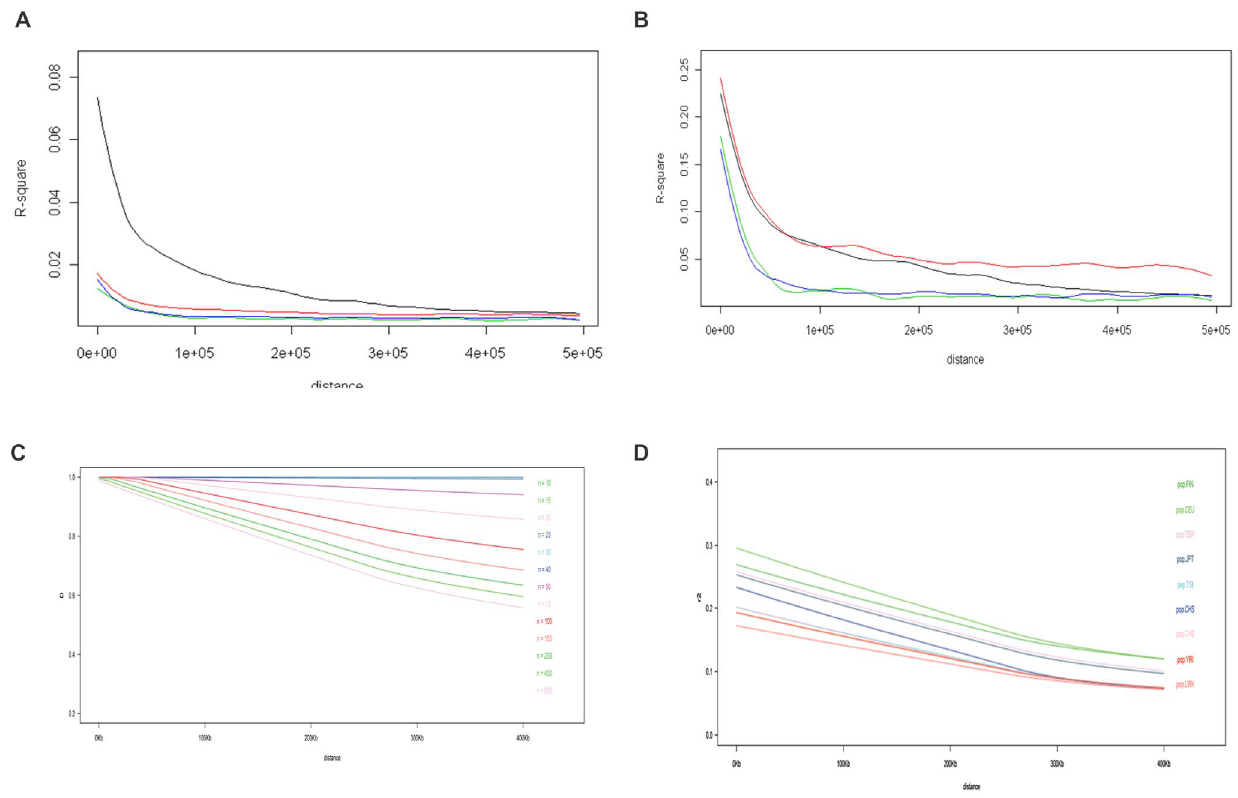
Figure 2. Across genomic region comparison of the Linkage Disequilibrium (LD) for variants with frequency lower than 5% (A), greater than 5% (B), and 90 th percentile of LD by D 9 (C) and R 2 (D) as a function of distance (kb) for various sample size as measure. (A) Across genomic region comparison of the LD decay (R-Square) in the 1000 genome samples for variants whose frequency is lower than 5% . (B) Across genomic regions comparison of the LD decay (R-Square) in the 1000 genome samples for variants whose frequency is greater than 5% . Chr6:28,850,000:33,750,000 (black) representing the MHC; Chr9:116,750,000:121,650,000 (green with similar variants’ density as MHC used in Fig. 1C); chr9:800,000:5,700,000 (blue with similar recombination rate as MHC used in FIG. 1D), an additional control with similar variants’ density chr8:9,400,000=red (with similar variants’ density as MHC), The plot is presented for 0–500 Kbp. In 2A, all markers are included in 2B only markers whose frequencies are greater than 5% are included, showing that the analysis is affected by low frequency variants which requires large sample size for accurate estimation. (C) Average 90 th Percentile of pairwise linkage disequilibrium (D 9 ) as a function of distance (kb) for various sample size . (D) Average 90 th Percentile of pairwise linkage disequilibrium (R2) as a function of distance (kb ranging from 0–400 Kb) for various sample sizes . (C and D) The AAMS dataset consists of 405 African American controls and 594 African American individuals with multiple sclerosis (MS) typed at 6040 MHC SNPs using Infinium iSelect HD Custom Genotyping BeadChip (Illumina). After strict quality control for missingness , 0.1% and minor allele frequency . 5%, 3224 markers remained for analysis. A subset of n=10 random control individuals was selected. Linkage disequilibrium (r2 and D 9 ) was calculated between all pairs of SNPs (5,195,476 unique pairs) using Haploview software. All r2 and d 9 estimates were sorted by distance between markers, and grouped into bins of 500 bases. The 90th percentile r2 and d 9 were calculated within each bin. Locally weighted regression (Cleveland, W. S. (1981) LOWESS: A program for smoothing scatterplots by robust locally weighted regression (The American Statistician, 35, 54) was used to create a smooth regression line across the 90th percentile r2 and d 9 measures. The line in the figure represents the median across 10 trials of re-sampling the n=10 individuals. The same procedure was repeated for larger sample sizes (n=15, 20, 25, 30, 40, 50, 75, 100, 150, and 200). For the largest sample sizes (n=400 and n=800), MS cases were included in the analysis. The Correlation between sample size and average LD measure at a distance of 400 kb is shown in Figure S3A and S3B in Supplementary material.